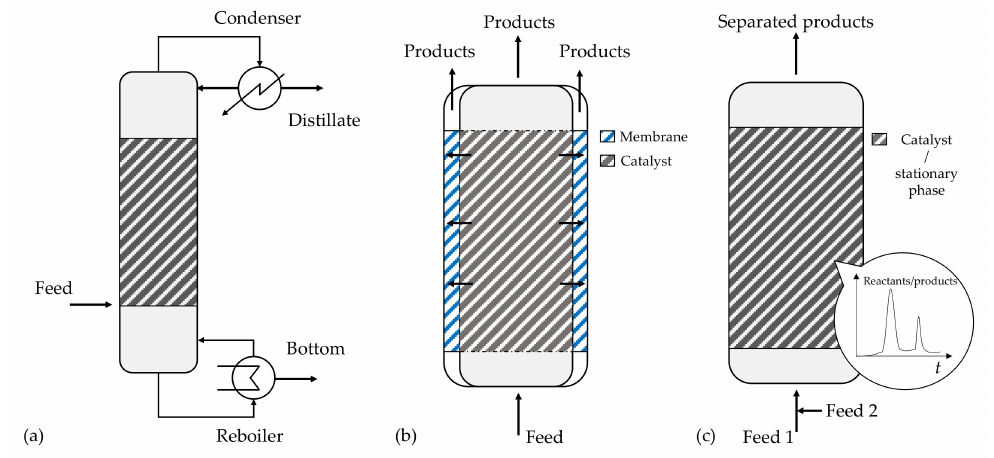
Figure 5. Sketch of multifunctional reactor units: ( a ) reactive distillation column; ( b ) membrane reactor; ( c ) chromatographic